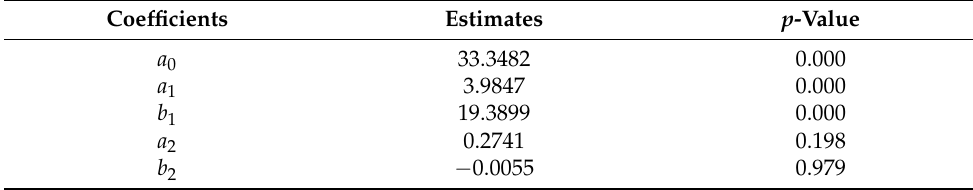
Table 3. S 2 harmonic regression